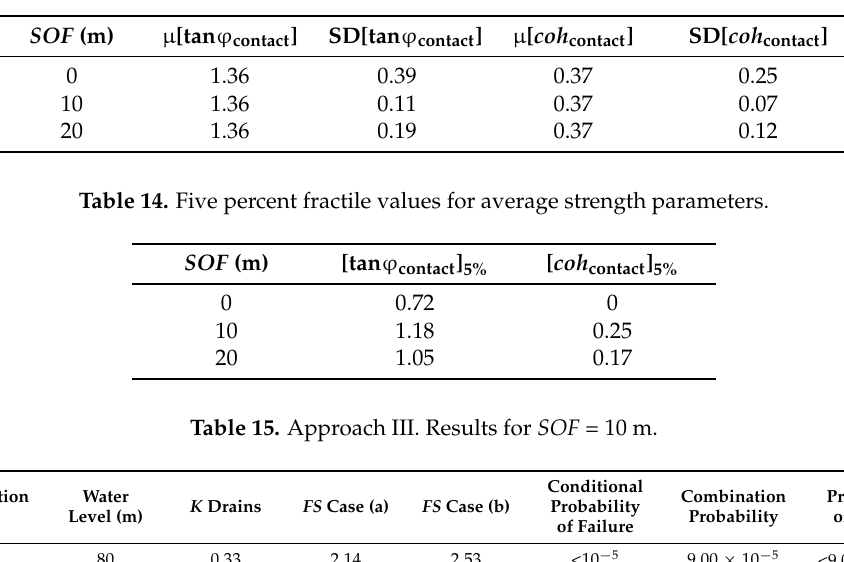
Table 13. Parameters of normal distributions for average friction coefficient and average cohesion.